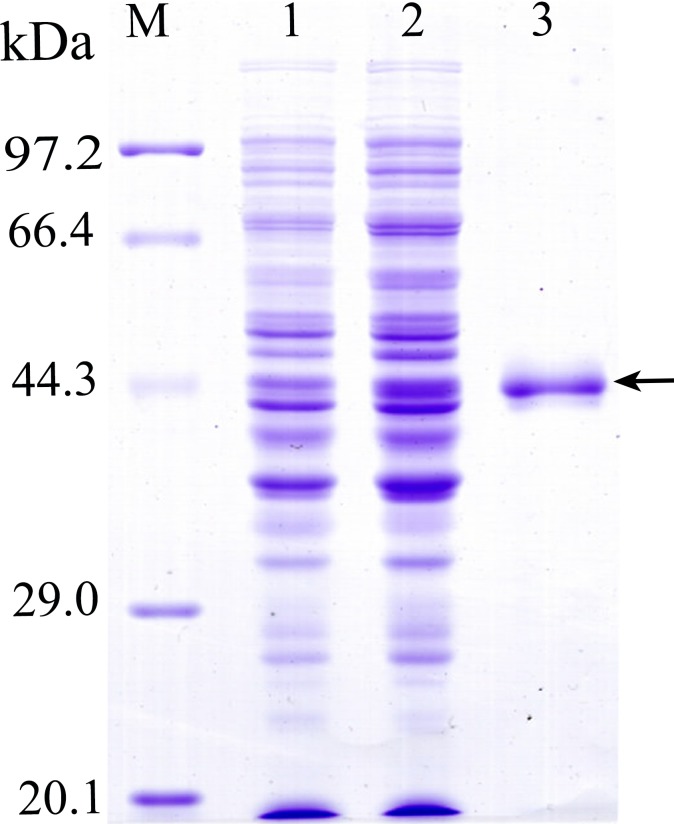
SDS-PAGE analysis of the rTsSP.M: protein molecular weight marker; 1: protein lysates from recombinant E. coli before being induced, 2: protein lysates of recombinant E. coli induced by IPTG; 3: rTsSP purified by Ni-NTA-Sefinose Column. Arrow indicates rTsSP.